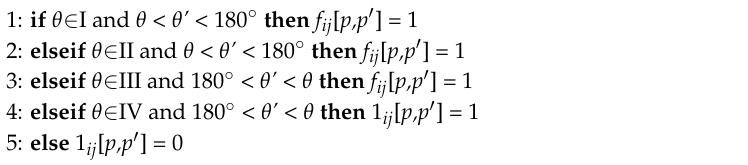
Algorithm 1. Jugement of the effect the relative motion direction of p (cid:48) on